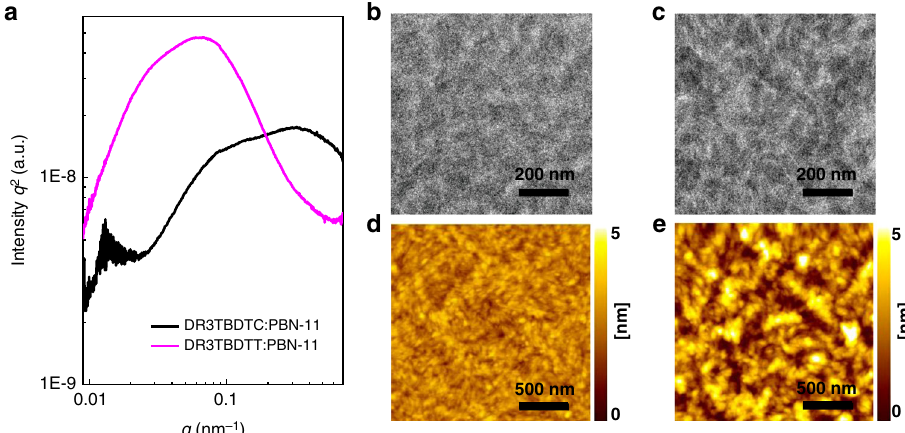
Fig. 5 Morphology of the blend fi lms. a R-SoXS pro fi les of DR3TBDTC:PBN-11 and DR3TBDTT:PBN-11 blend fi lms. TEM images of b DR3TBDTC:PBN-11 and c DR3TBDTT:PBN-11 blend fi lms. AFM height images of d DR3TBDTC:PBN-11 and e DR3TBDTT:PBN-11 blend fi